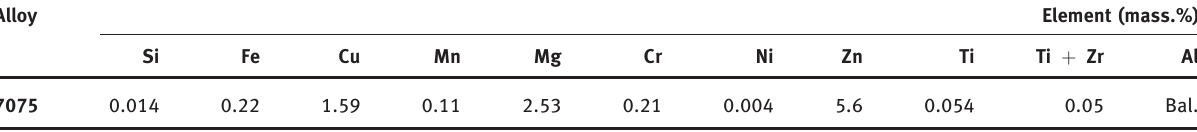
Table 1: Chemical composition of